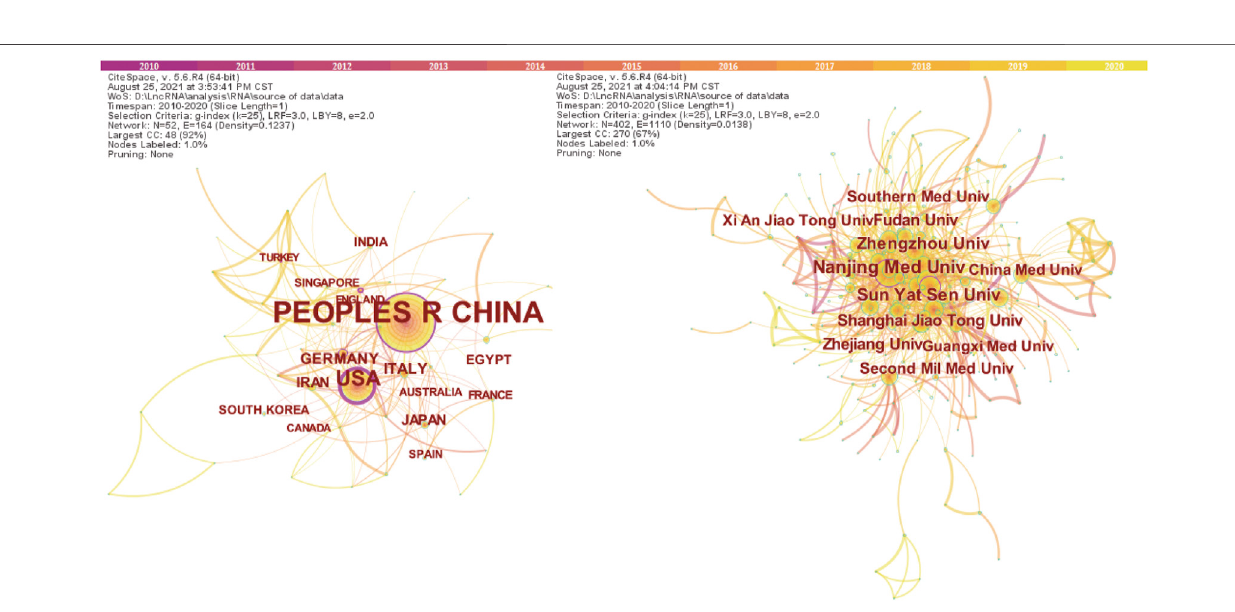
Frontiers in Genetics |